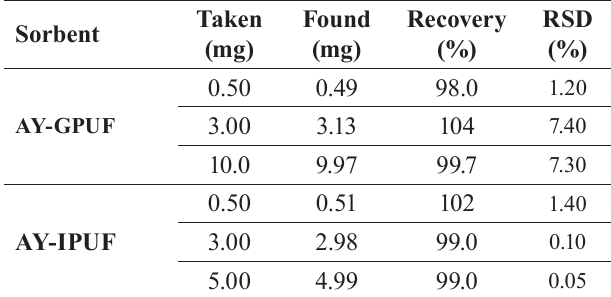
TABLE IV - Accuracy of the proposed methods for CAF determination by add-found